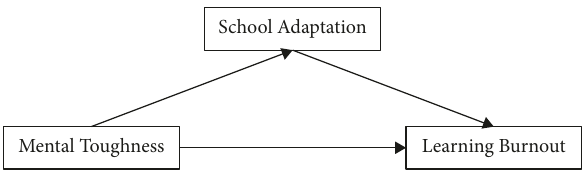
Figure 1: Research framework